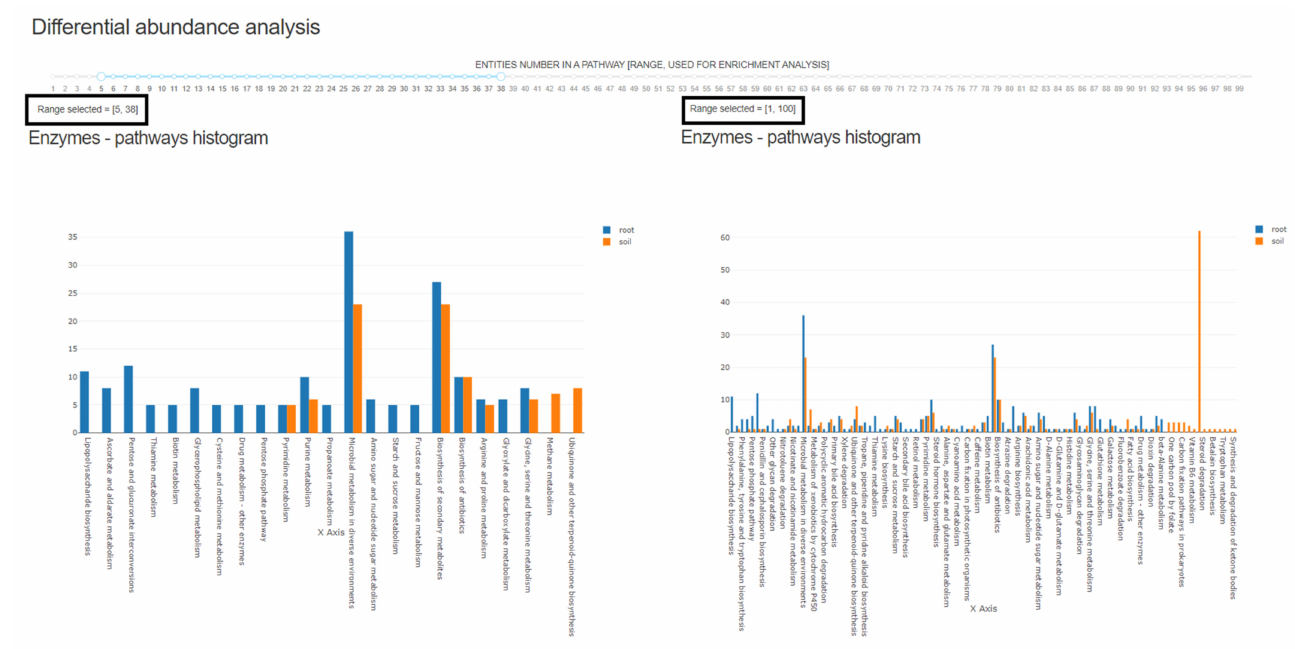
Figure 2. The effect of minimal/maximal pathway size on data presentation. The mapping of differentially abundant enzymes to pathways with ( left ) and without ( right ) filtration of minimal and maximal entities per pathway as selected by the user in the menu shown on